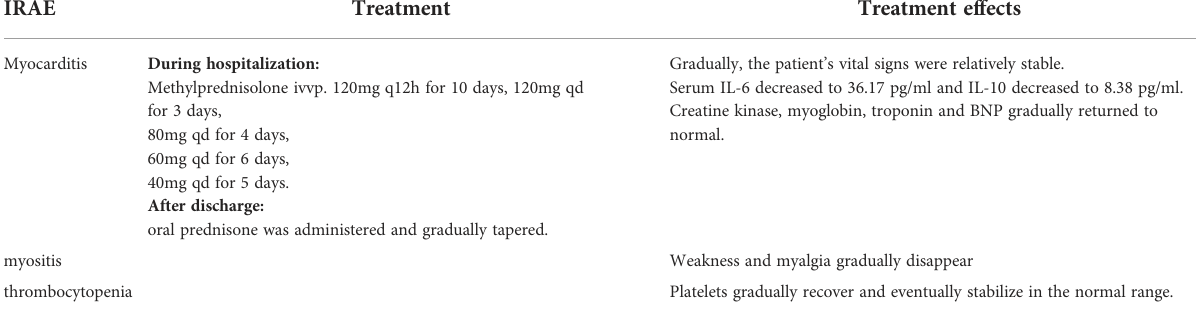
TABLE 1 The administration of immune-related toxicity and the effect of treatment. IRAE